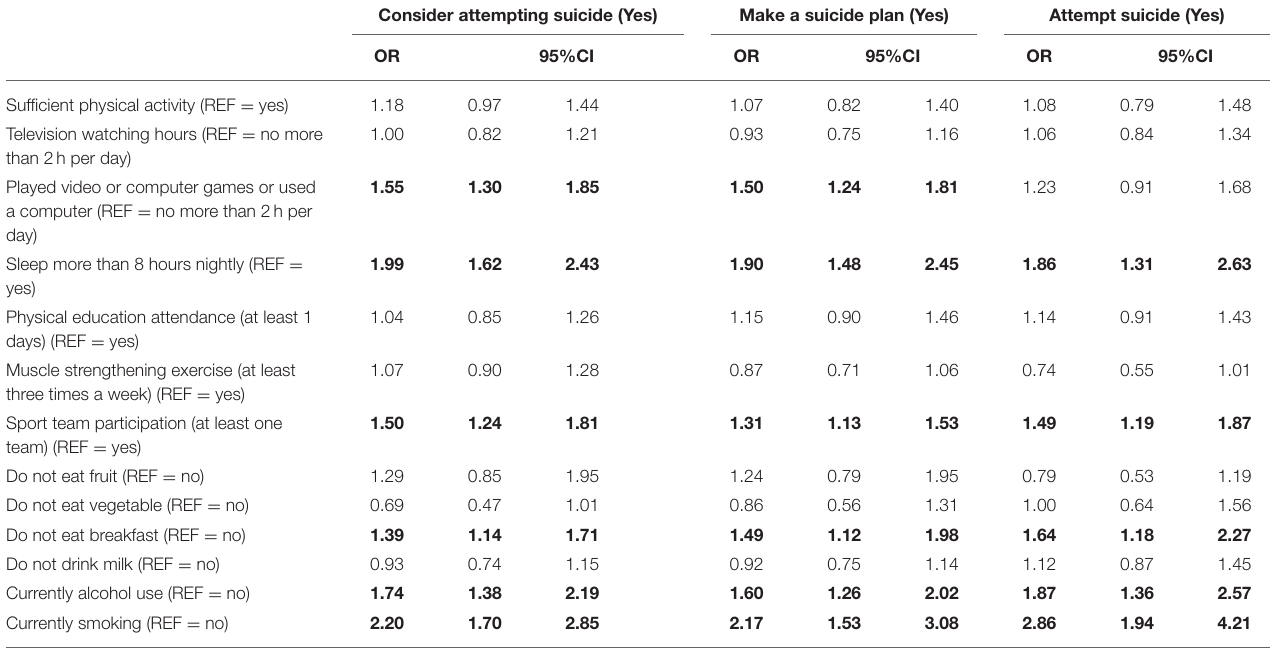
TABLE 3 | Factors associated with suicide-related behaviors (consider attempting suicide, make a suicide plan and attempt suicide). Consider attempting suicide (Yes) Make a suicide plan